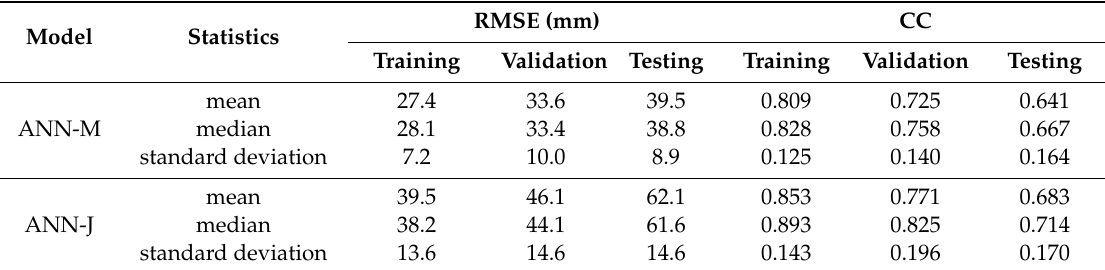
Table 5. Summary of the performance statistics of the optimal ANN-M and ANN-J model.